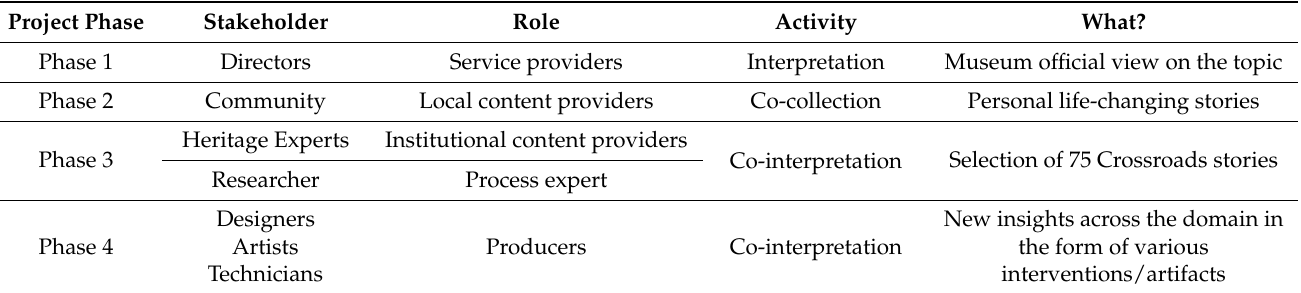
Table 4. Contributors to the development of Brabant